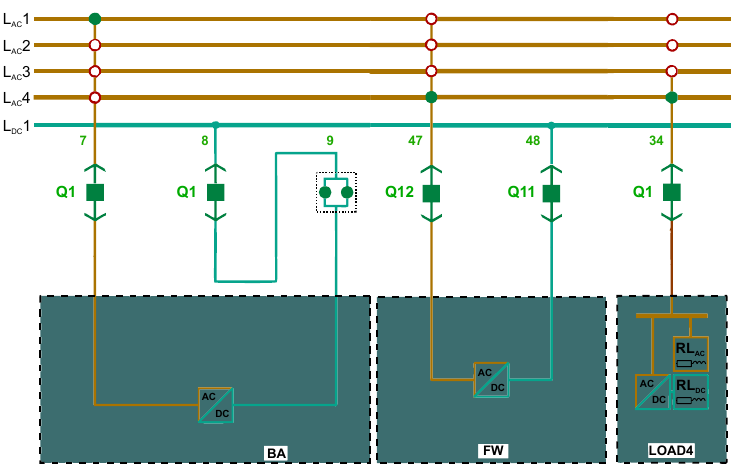
Figure 7. Diagram of the LINTE 2 laboratory functional units used in the PHIL testing of the syn- chronous generator